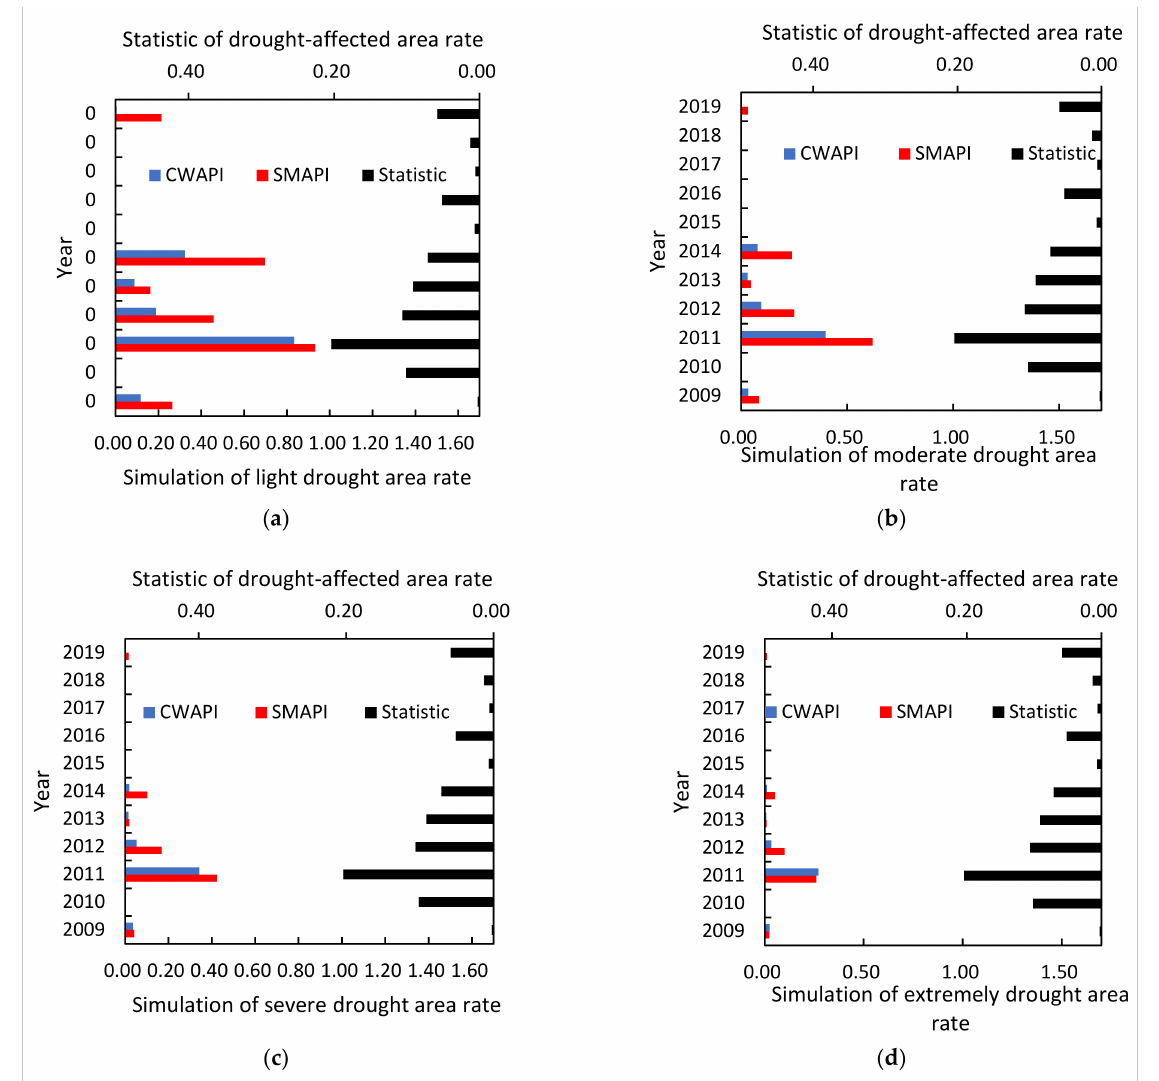
Figure 5. Bar diagrams of the statistical values of drought-affected area rates and the area rates of different drought grades in Jiangsu Province from 2009 to 2019 ( a – d correspond to light, moderate, severe, and extremely drought area rates,